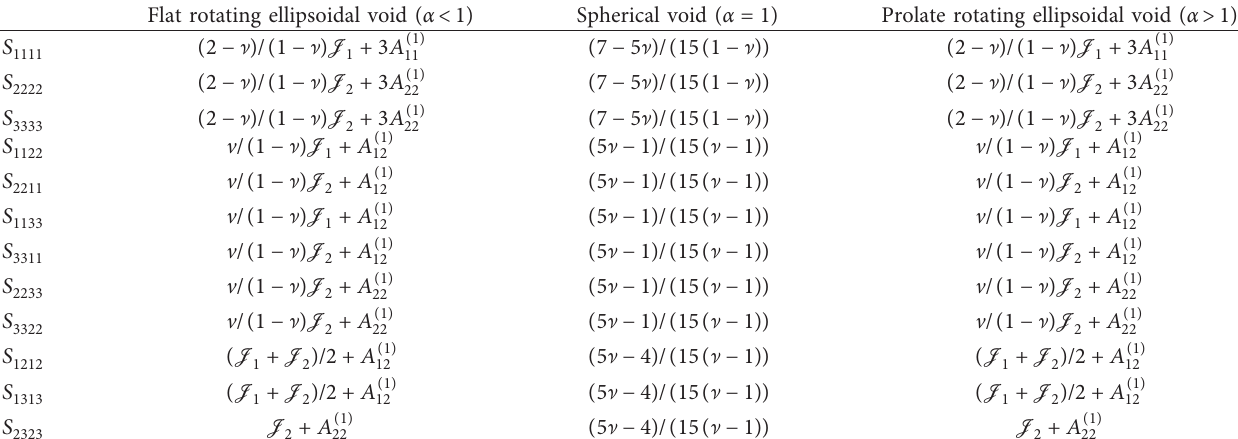
Table 8: Components of Eshelby tensor for void inclusion.